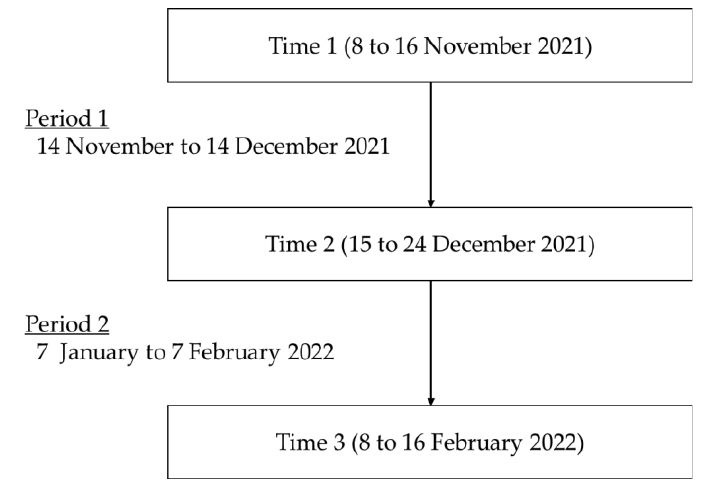
Figure 1. The timeline of the survey. The maximum and minimum mean scores for the eight emotions are shown in Table 3.